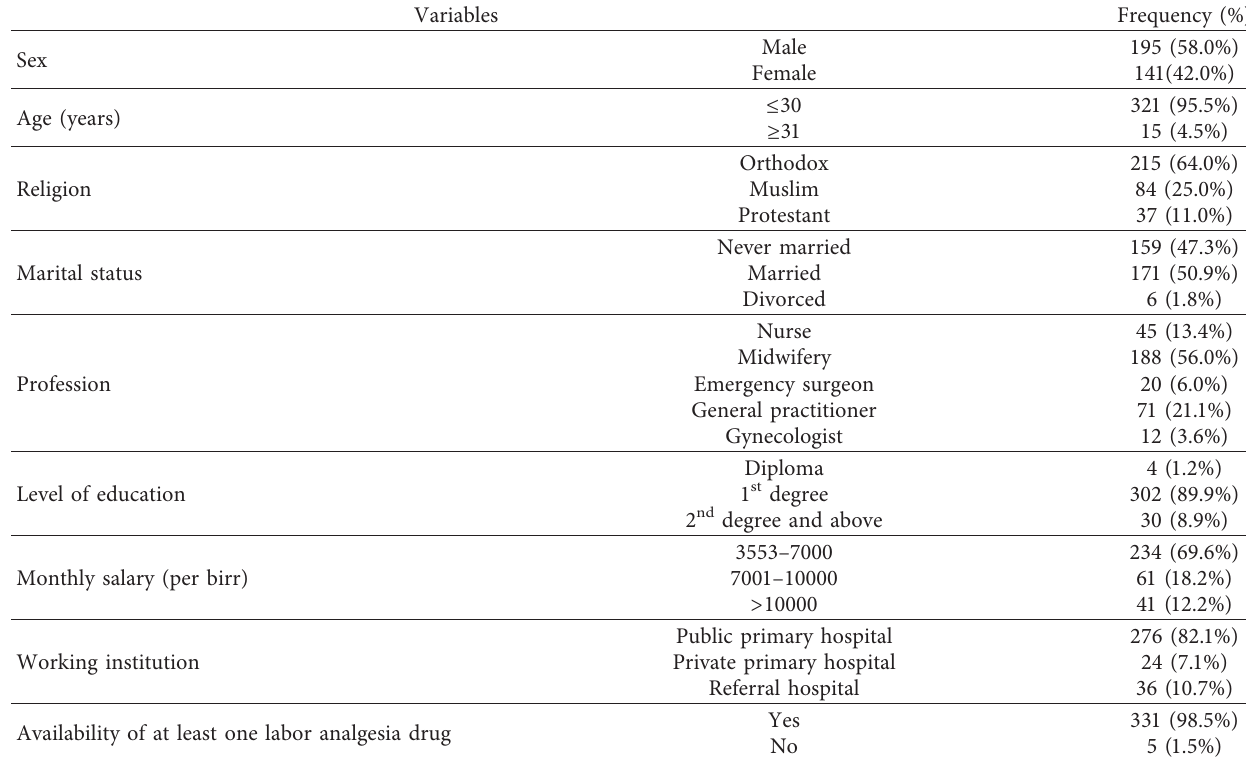
Table 1: Sociodemographic characteristics of SBAs working at hospitals in Gondar zones, northwest Ethiopia, 2019.